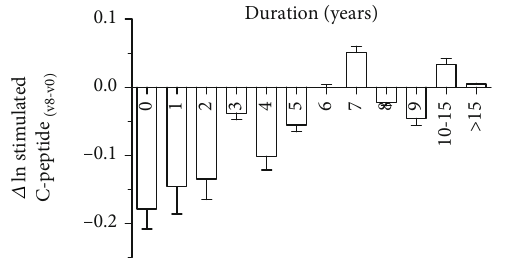
Figure 2: Decline of stimulated C-peptide over 2 years (from v0 to v8). The di ff erence of C-peptide between v8 and v0 by self- comparison in T1DM with di ff erent diabetes duration was processed with logarithm in order to re fl ect the changes of islet β - cell function intuitively. Among those with a duration of ≤ 5 years, a log-linear decline of stimulated C-peptide was observed during individuals with diabetes duration 0 to 5 years ( P < 0 : 01 ). However, among those with a duration of ≥ 5 years, changes of stimulated C- peptide levels were irregular. V0: the 0th visit; V8: the 8th curve was 0.733 (95% con fi dence interval 0.673-0.793), and